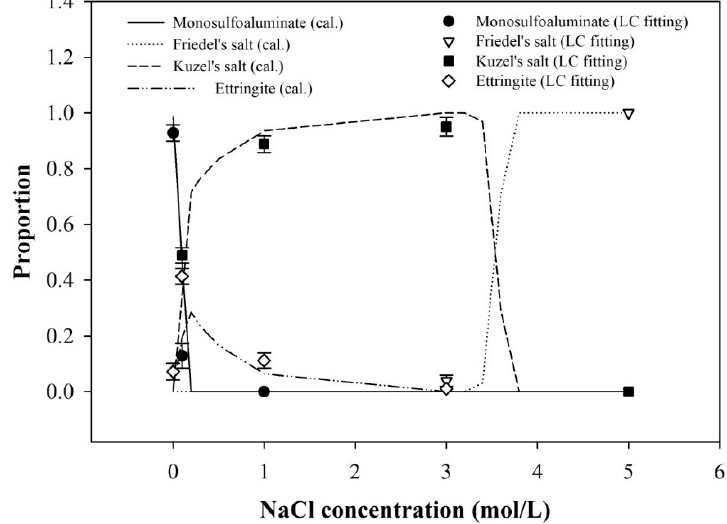
Figure 4. Calculated molar phase fractions from thermodynamic calculation (cal. in legend) and LC fitting of XANES spectra (LC fitting in legend) with different NaCl concentrations.